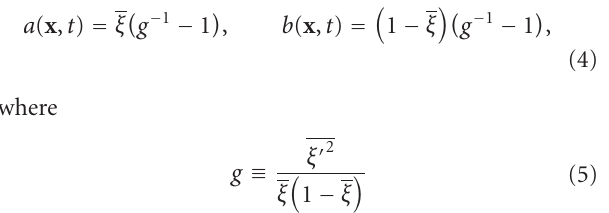
delta functions at g (cid:5) 1 and 1 − g (cid:5) 1, respectively, see Figure 1. For instance, if a < 1 (or b < 1), then the PDF given by (3) tends to infinity and resembles Dirac delta function at ξ → 0 (or ξ → 1). However, contrary to Dirac delta function, substitution of (3) into the integral (cid:2) → 0 yields vanishing probability of finding ξ = 0, for example, vanishing probability of finding unburned mixture in the case of premixed combustion ( ξ = c ). Indeed, if c (cid:5) 1 and g di ff ers markedly from zero and unity, then, a (cid:5) 1, Γ ( a + b ) ≈ Γ ( b ), and the above integral is